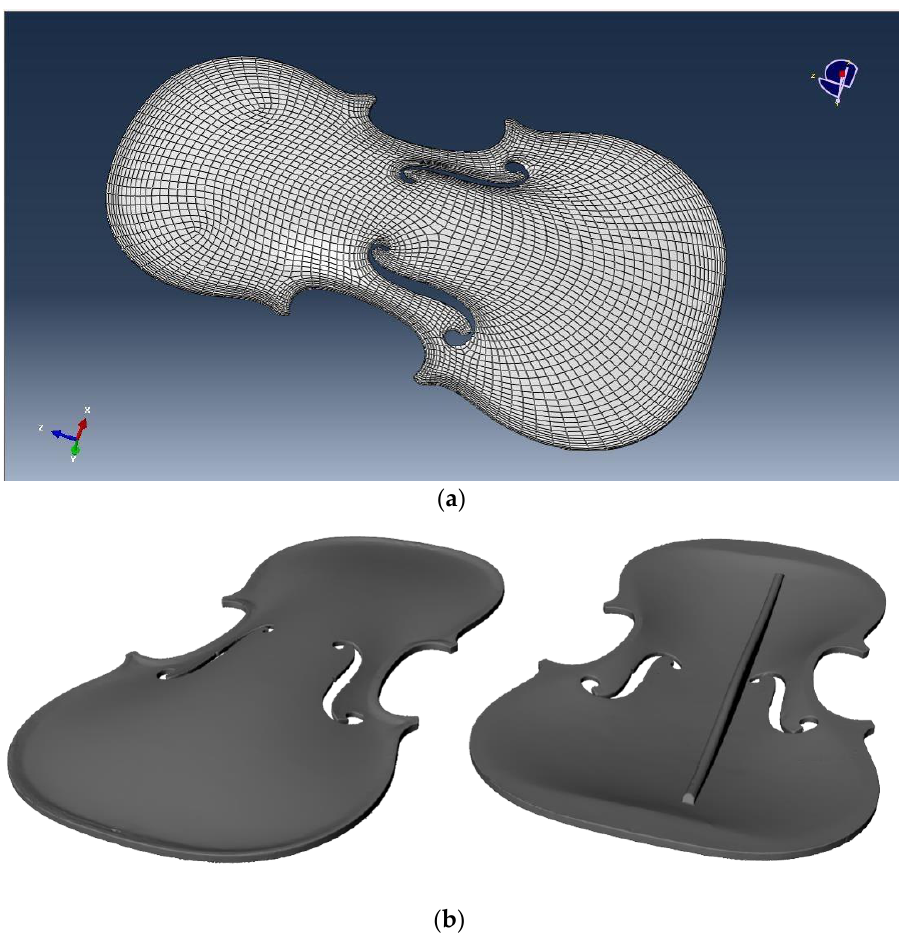
Figure 12. The retopologised model of the of the soundboard of the violin ( a ) and the NURBS obtained of both the soundboard and the back of the violin ( b ).